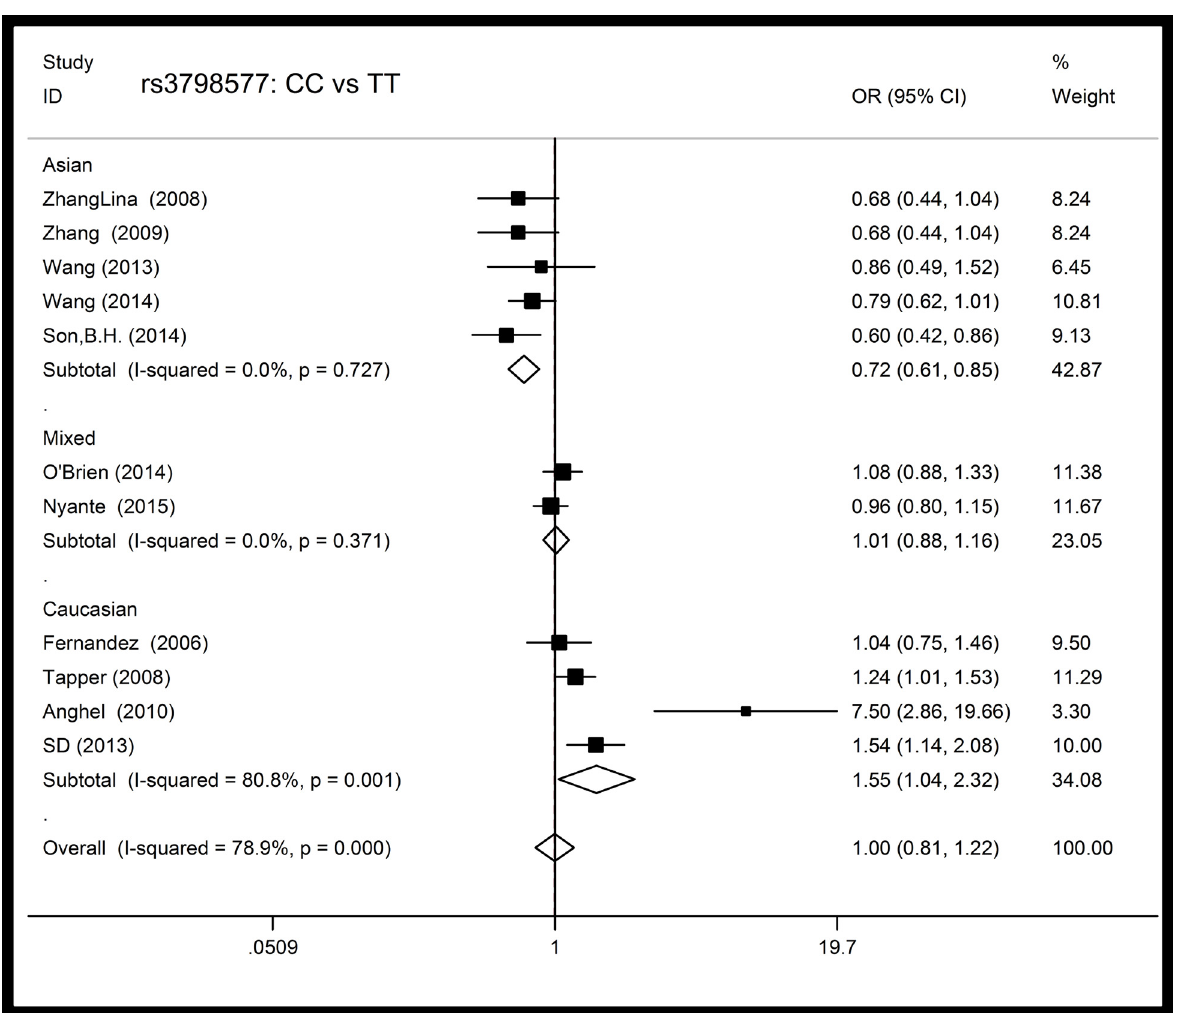
Fig 4. Forest plot of the association between rs3798577 and breast cancer risk in different ethnicities in the variant homozygote versus wild-type homozygote